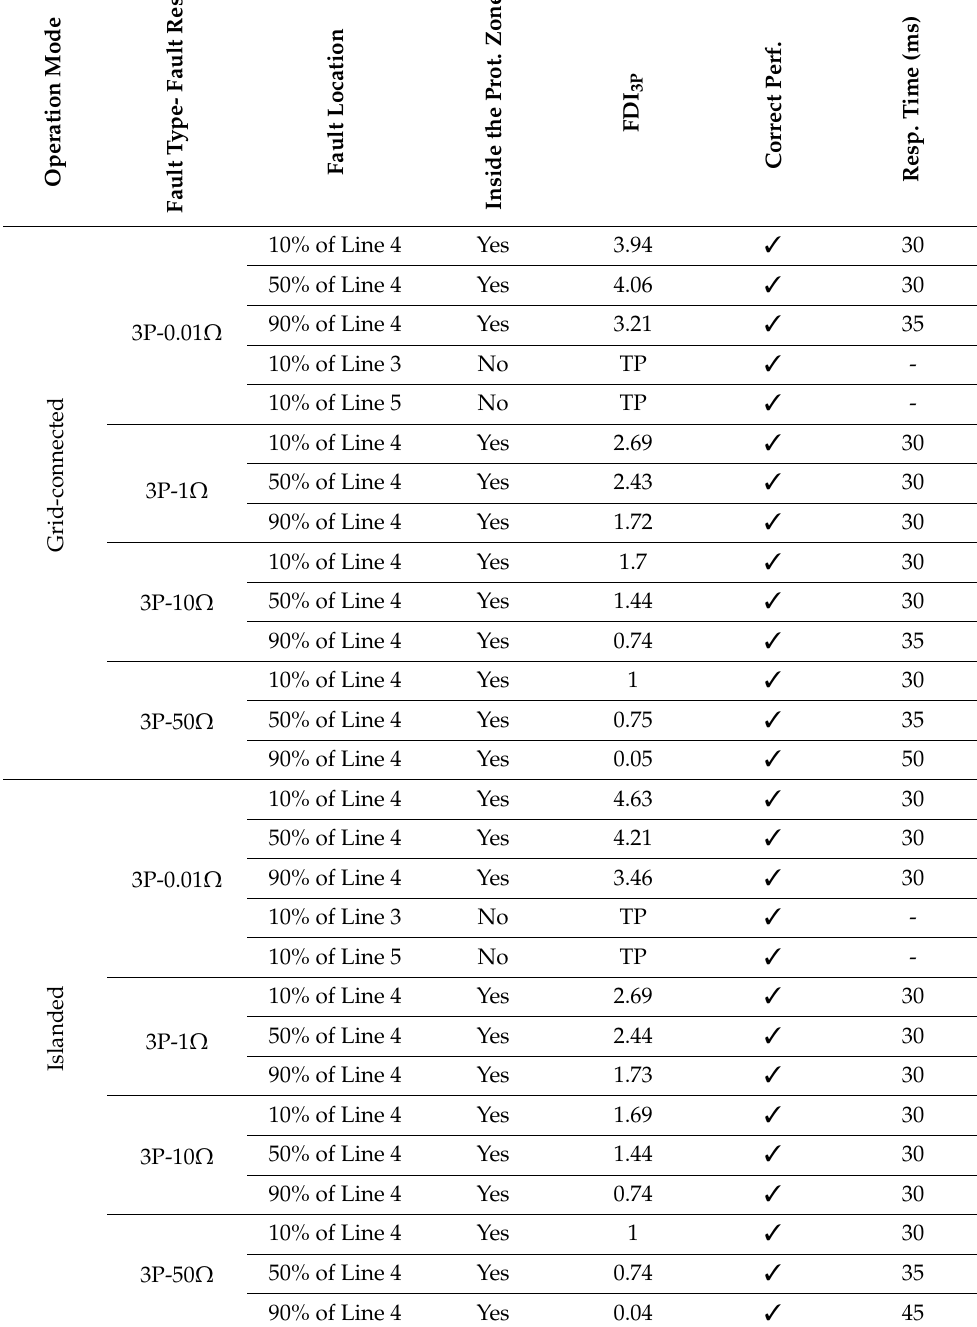
Table 1. Performance of the proposed main scheme in 3P